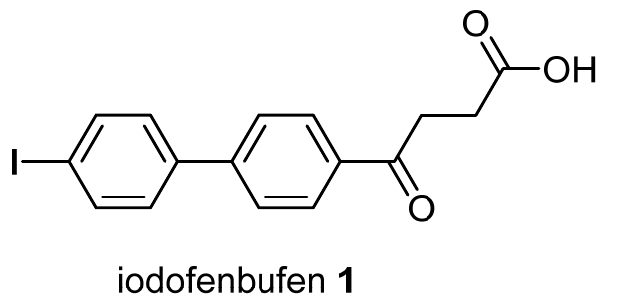
Figure 1. Fenbufen analog as lead compound of this study.